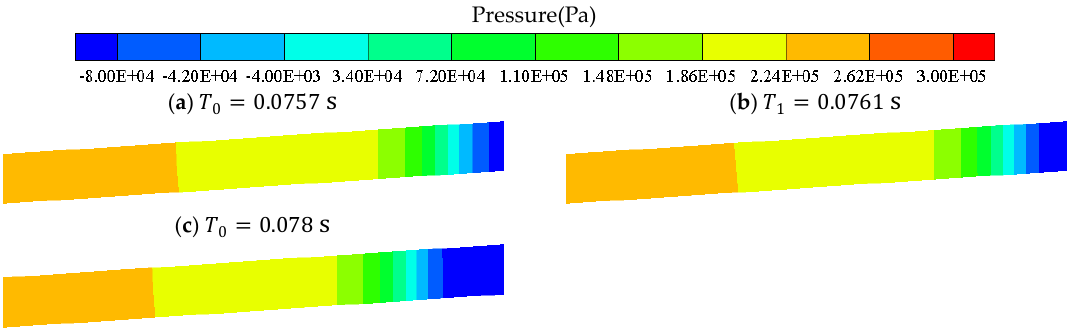
Figure 31. Pressure field evolution on the axis plane of the pipeline in the cavity growth stage.